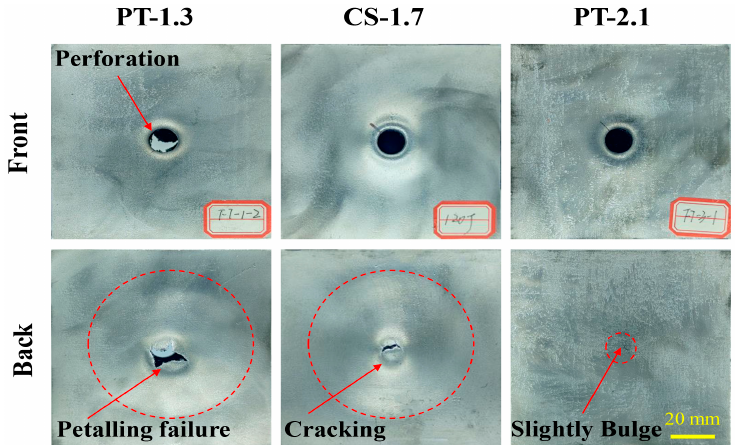
Figure 10. Failure modes of panels of AFS with different panel thicknesses.